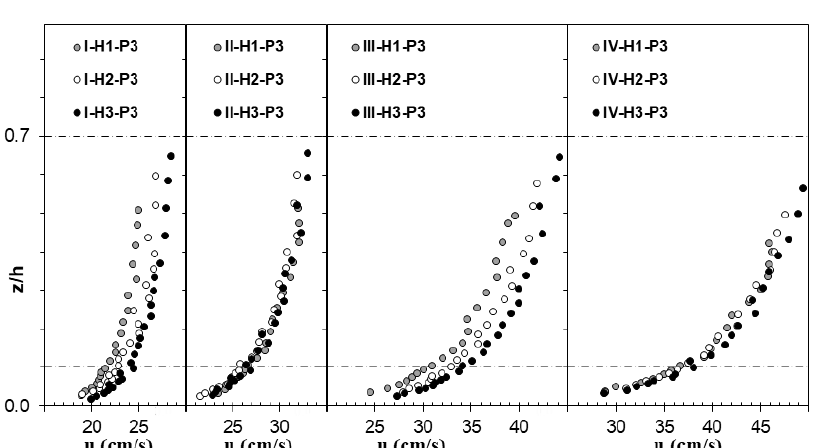
Neill Difference with Equation (7) Value Garde Difference with Equation (7)